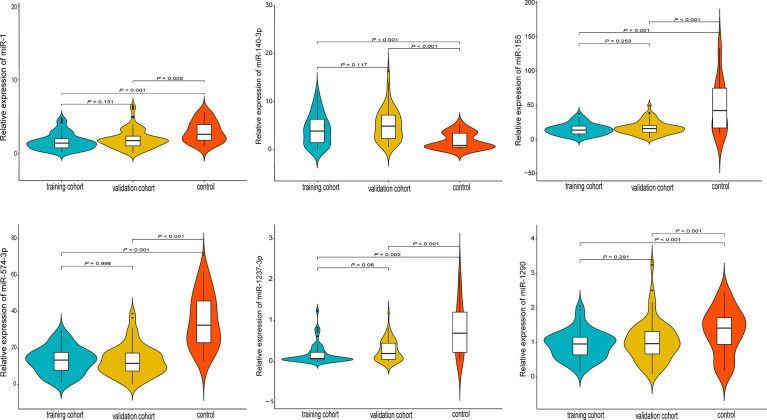
Quantitative expression levels of the six prognostic miRNAs by RT-PCR in the training, validation and control groups. All miRNAs were differentially expressed in tumor tissues compared with nucleus pulposus tissues (as controls).